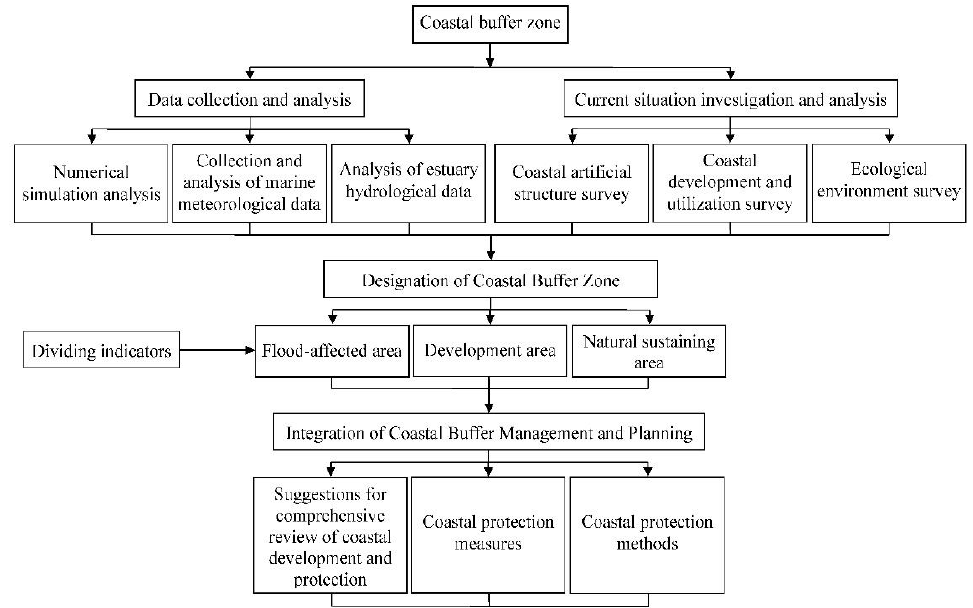
Figure 11. Research framework for the establishment and management of coastal buffer zones.